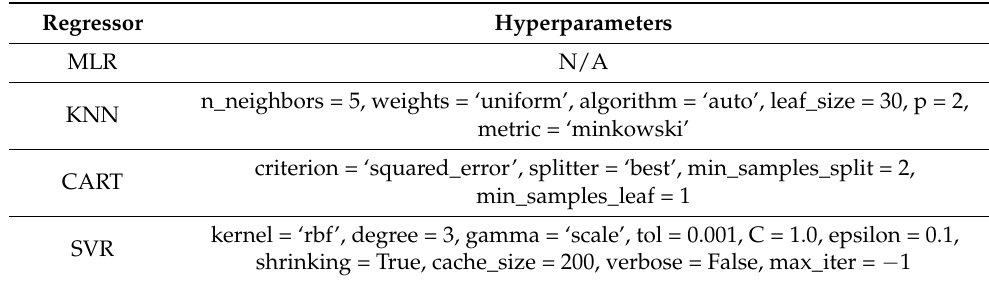
Table 2. Hyperparameters used in the train and test datasets for the nine algorithms implemented without